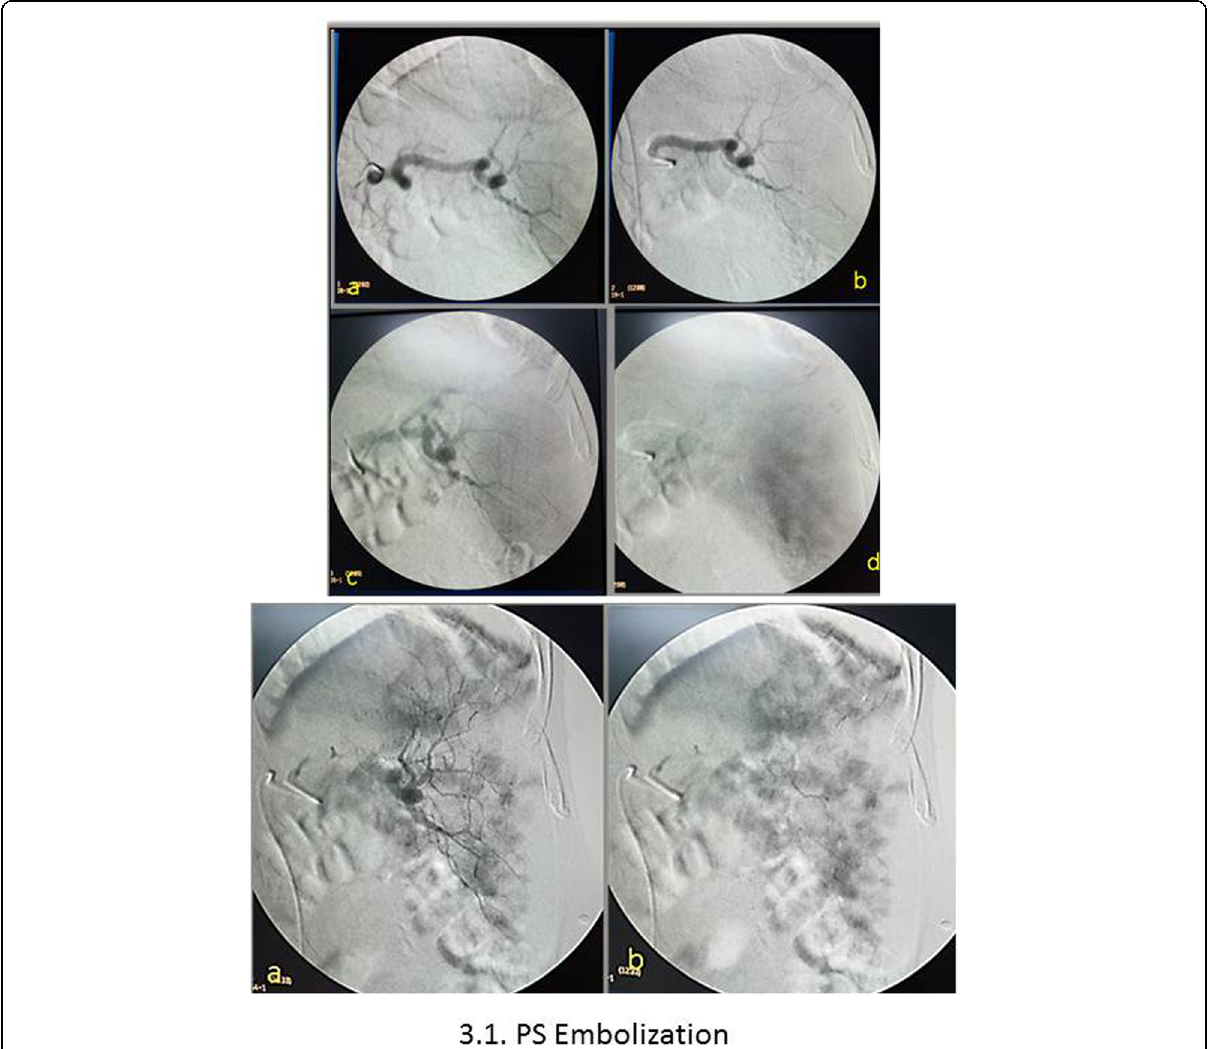
Fig. 5 Male patient, 57 years old, with thrombocytopenia corrected only by fresh frozen plasma transfusion. a , b Selective DSA of splenic artery before embolization showing splenic artery and its segmental divisions. c , d Delayed images showed the parenchymal phase. DSA post- embolization. a , b Multiple areas of splenic infarctions about (70%) of the splenic